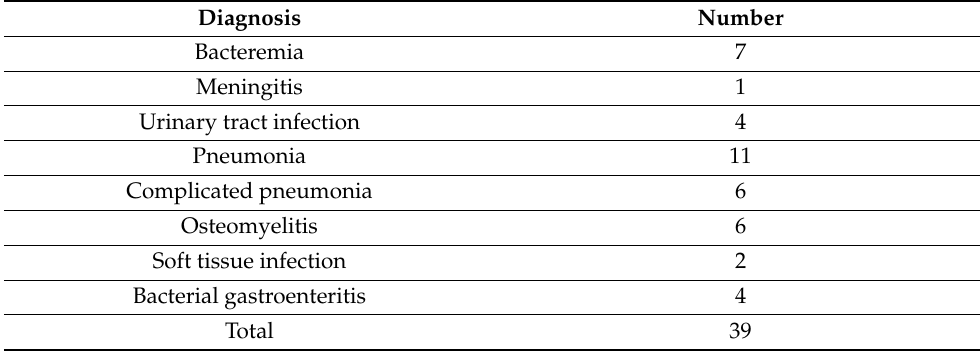
Table 3. Final diagnoses of SBIs in